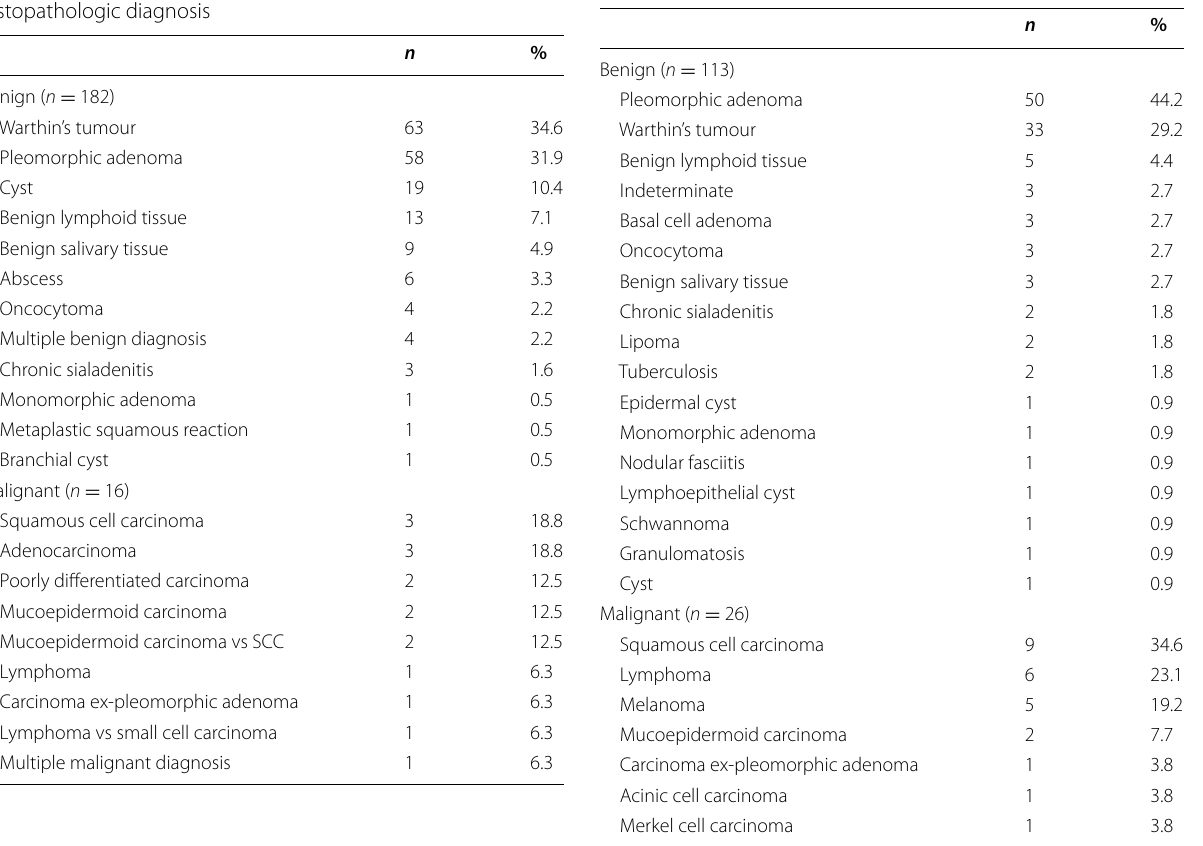
Table 2 Histopathologic diagnosis of parotid gland